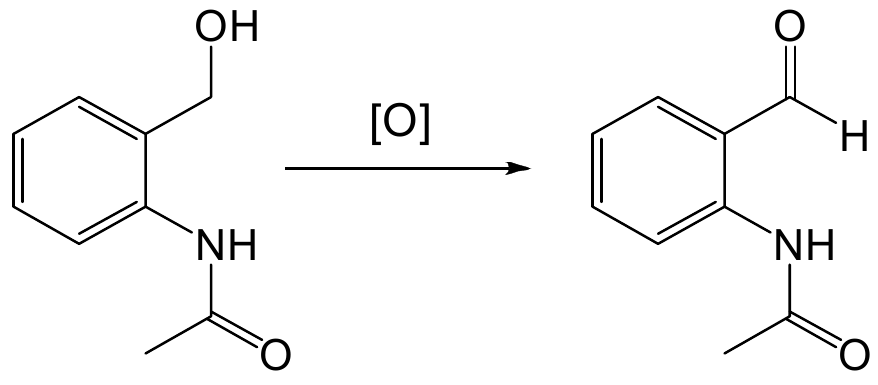
Table 1. Oxidation conditions investigated. a Isolated yield. b Only starting material isolated. c Incorrect product isolated, mono-chloro substitution occurred (Scheme 5). Entry